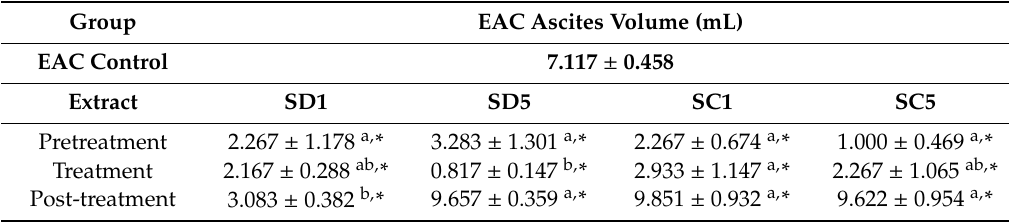
Table A1. Impact of S. montana extracts on the volume of ascites.